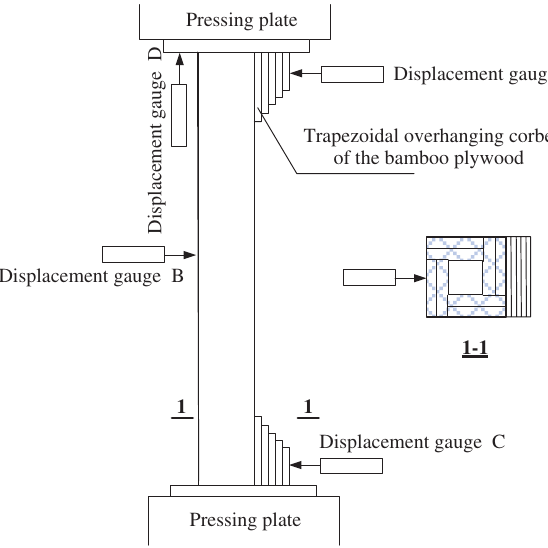
Figure 8: Schematic of the experimental apparatus.